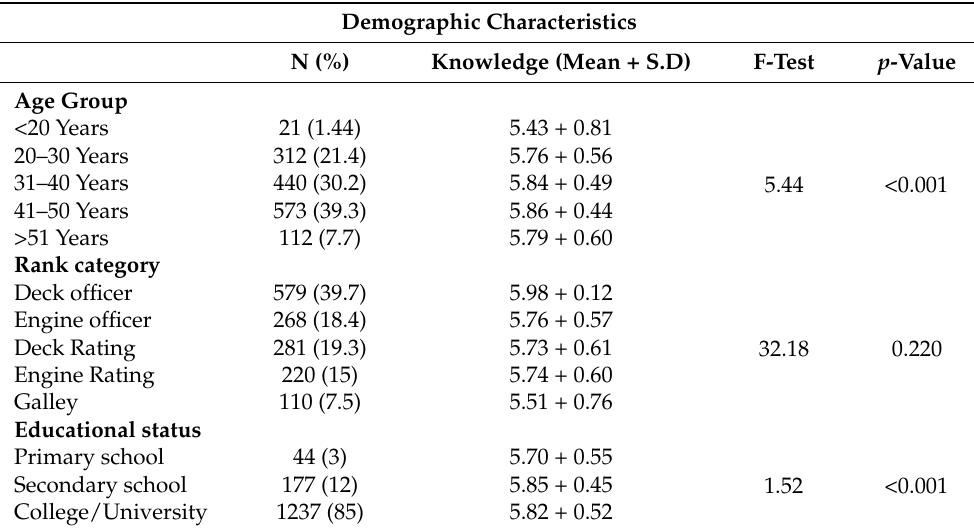
Table 4. Background characteristics of seafarers and knowledge scores of COVID-19 by age, rank, and educational